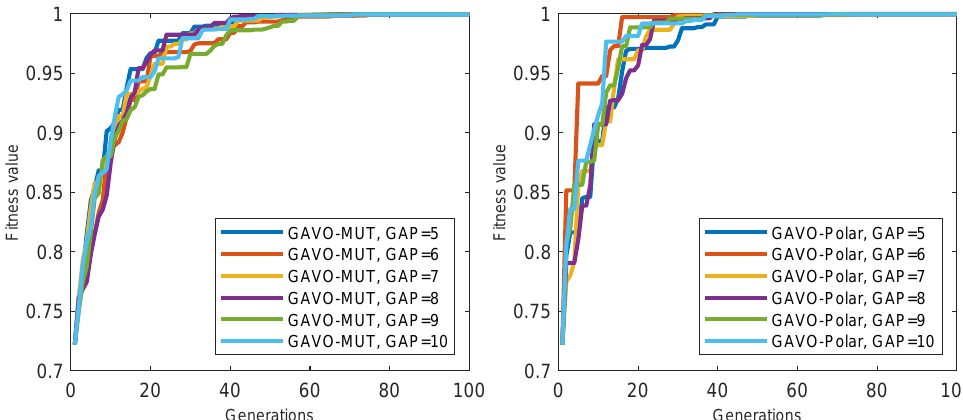
Figure 9. Results of experiments with the sparse scenario for the different GAP parame- ters. ( left ) Evolution of the fitness value with the generations using the GAVO-MUT method, ( right ) Evolution of the fitness value with the generations using the GAVO-Polar